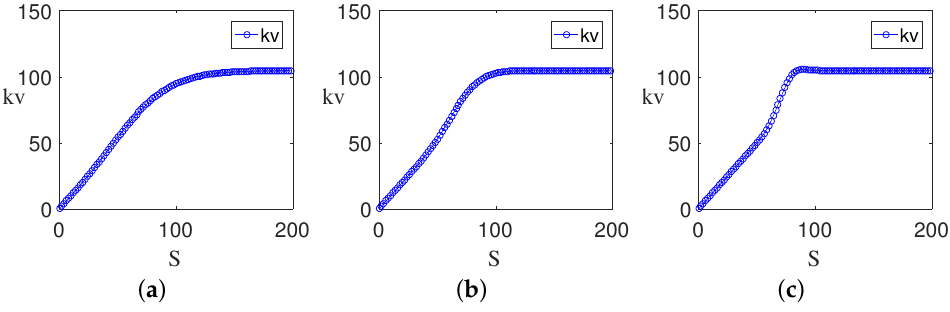
Figure 3. ( a ) denotes kv for different S when H = 0.3, ( b ) denotes kv for different S when H = 0.5 and ( c ) denotes kv for different S when H = 0.7.